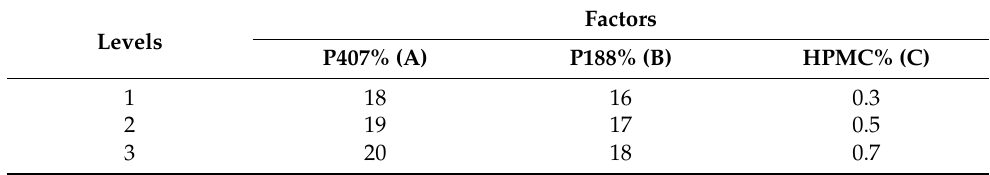
Table 1. Factor and level of orthogonal design